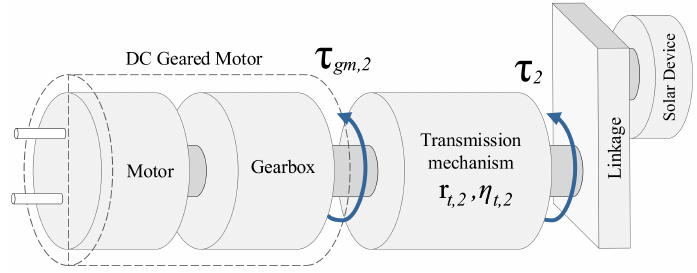
Figure 5. Schematic view of power-train of the elevation